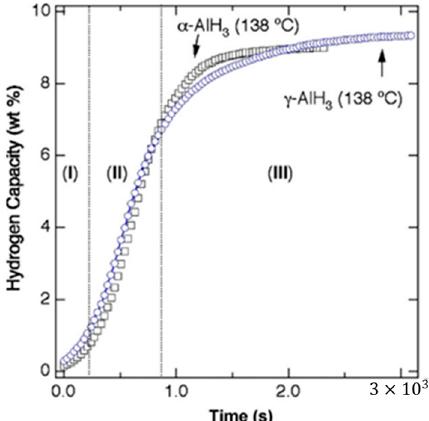
Figure 10. High temperature isothermal decomposition curves from α and γ -AlH 3 starting materials at 138 ◦ C showing ( I ) induction period ( II ), acceleratory period, and ( III ) decay period. Reprinted with permission from Ref. [63]. Copyright 2007